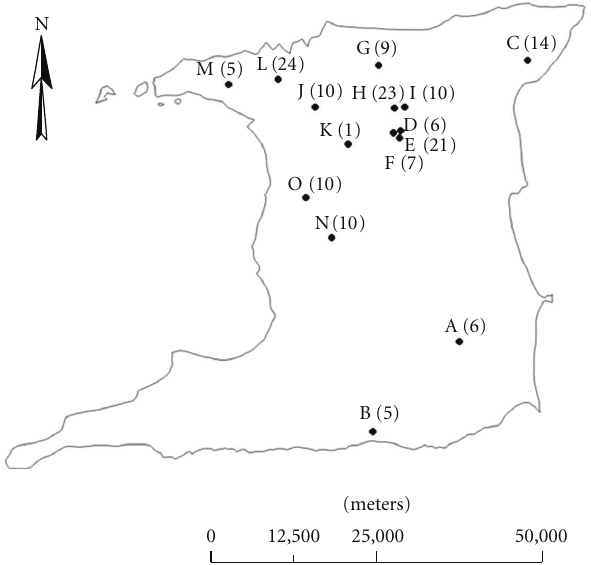
Figure 1: Map of Trinidad showing location of stud farms where foals (number of samples in bracket) were sampled for